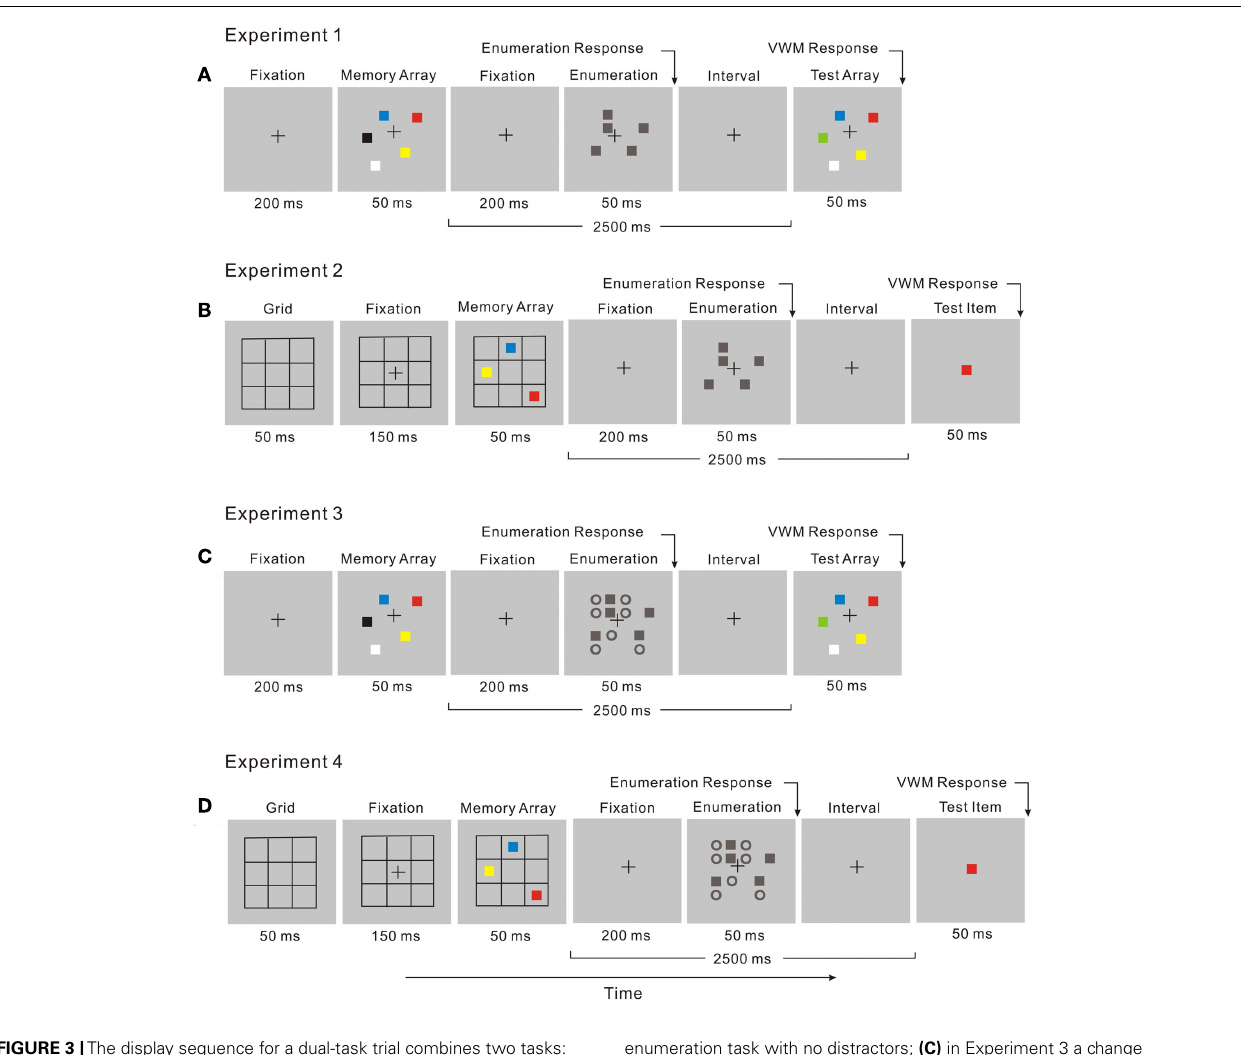
FIGURE 3 | The display sequence for a dual-task trial combines two tasks: (A) in Experiment 1, a change detection task and an enumeration task with no distractors; (B) in Experiment 2, a location recall task and an